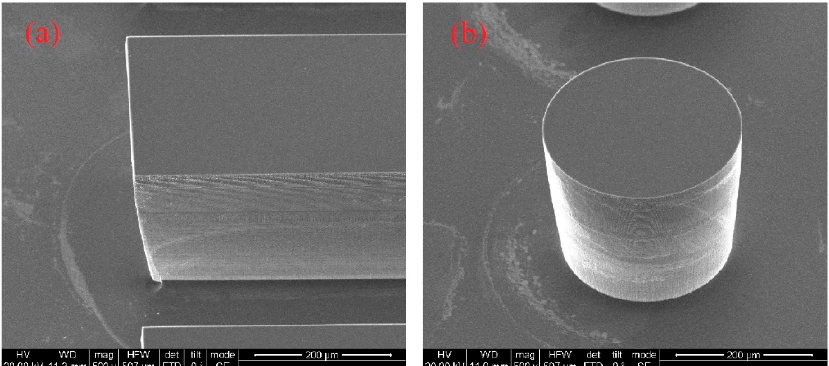
Figure 3. Fabrication process of the test chips.